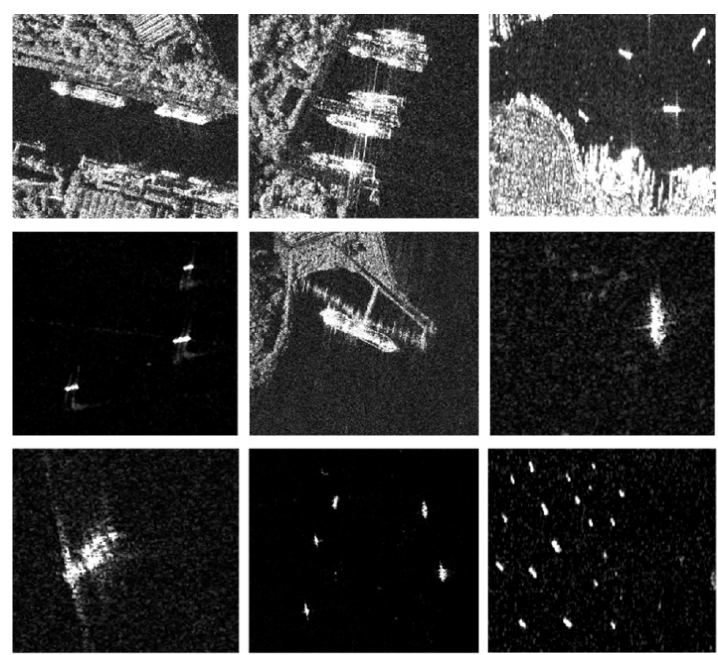
Figure 5. Illustration of the diversity of ship targets in the SSDD dataset. Table 2. Correspondence between NoS and NoI in the SSDD dataset.